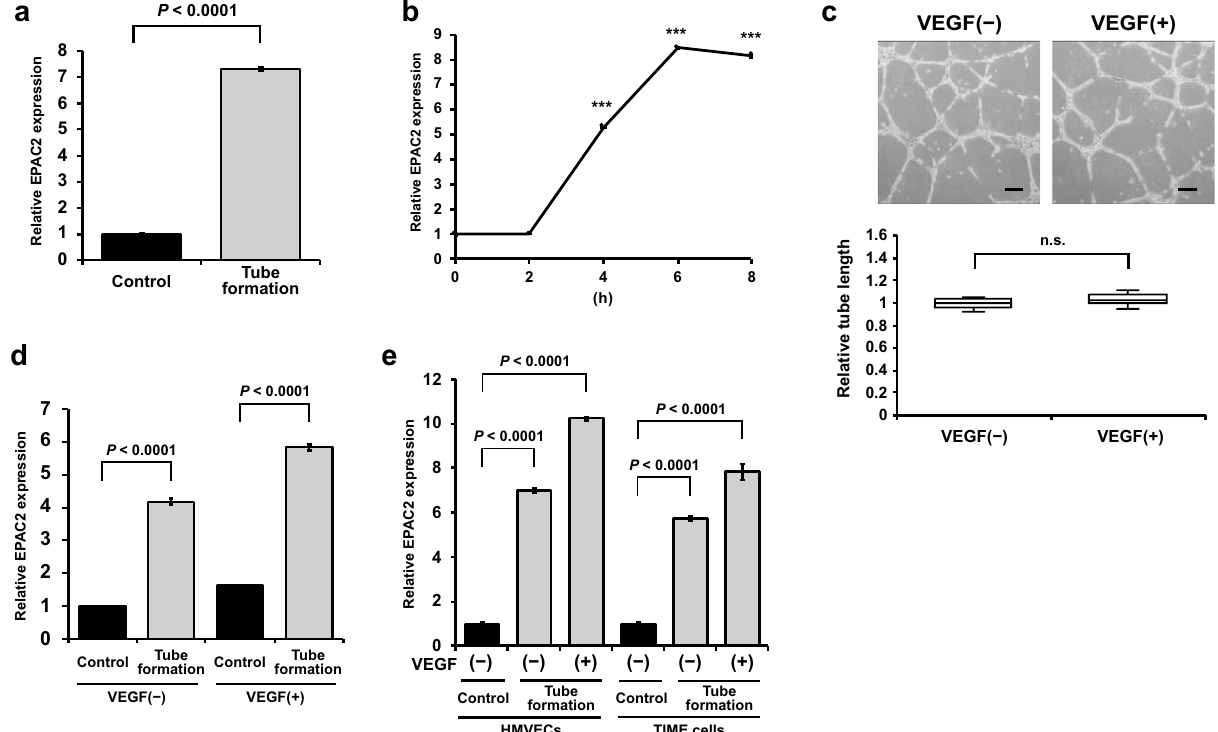
Figure 2. EPAC2 expression in endothelial cells during in vitro tube formation. ( a ) RT-qPCR confirmed EPAC2 expression during tube formation. Data were expressed as mean ± S.E.M. (n = 3). ( b ) Time-course experiment of the EPAC2 expression. HMVECs were cultured on Matrigel in the presence of VEGF, and total RNAs were prepared at the indicated time. Data were expressed as mean ± S.E.M. (n = 3). *** P < 0.001 versus 0 h. ( c ) VEGF is not necessary for the tube formation of HMVECs. HMVECs were cultured on Matrigel in the presence or absence of VEGF, and tube lengths were analyzed at 8 h as described in the Methods section (n = 10). The box represents the 25–75th percentiles, and the median is indicated. The whiskers show the maximum and minimum values. Scale bars: 200 μm. ( d ) EPAC2 expression was increased by tube formation but not VEGF. HMVECs were cultured on Matrigel in the presence or absence of VEGF for 8 h, and RT-qPCR was used to analyze EPAC2 mRNA levels. Data were expressed as mean ± S.E.M. (n = 3). ( e ) EPAC2 expression was increased in HMVECs and TIME cells. HMVECs and TIME cells were cultured on Matrigel in the presence or absence of VEGF for 8 h, and RT-qPCR was used to analyze EPAC2 mRNA levels. Data were expressed as mean ± S.E.M. (n =